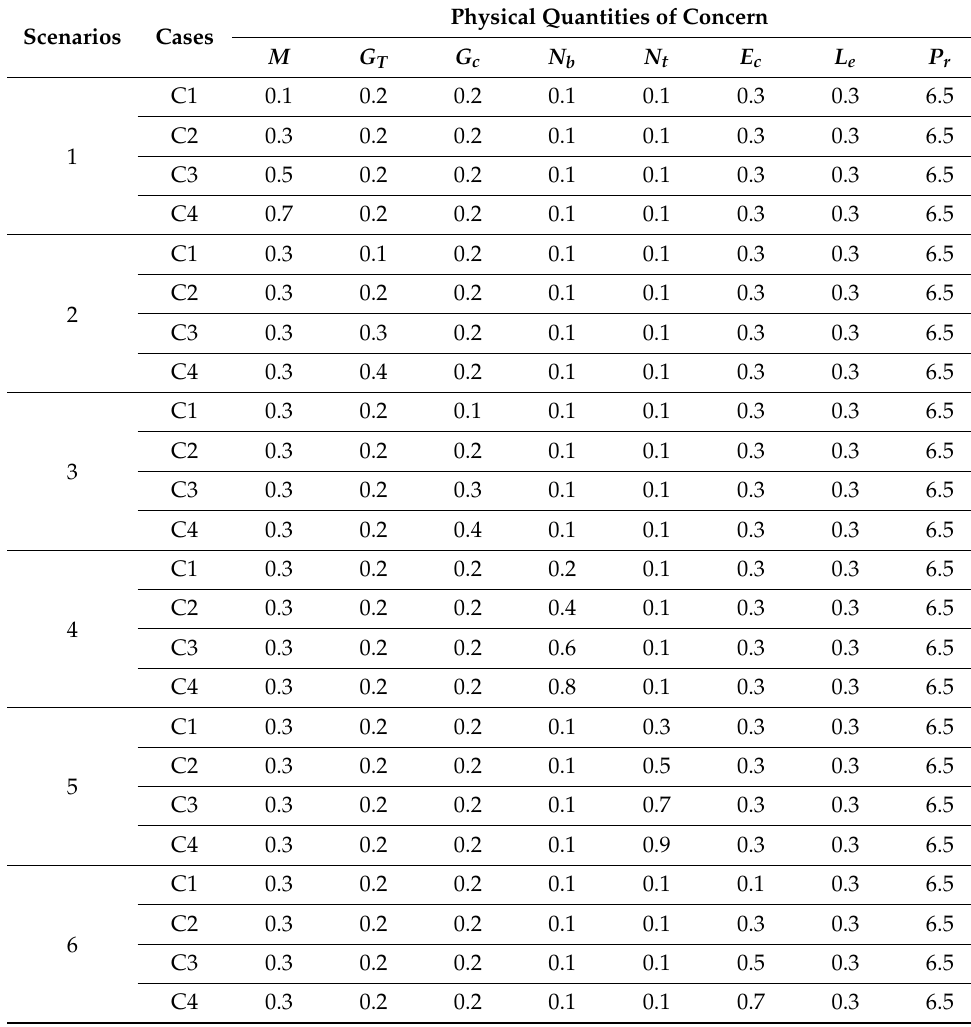
Table 2. Scenarios interpretation beside with cases for HTM-BFN model with